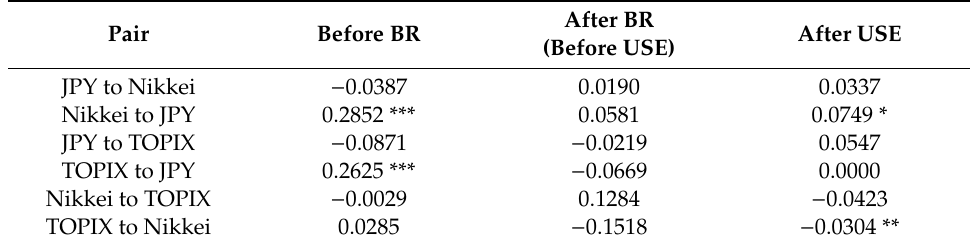
Table 3. Causality in mean.